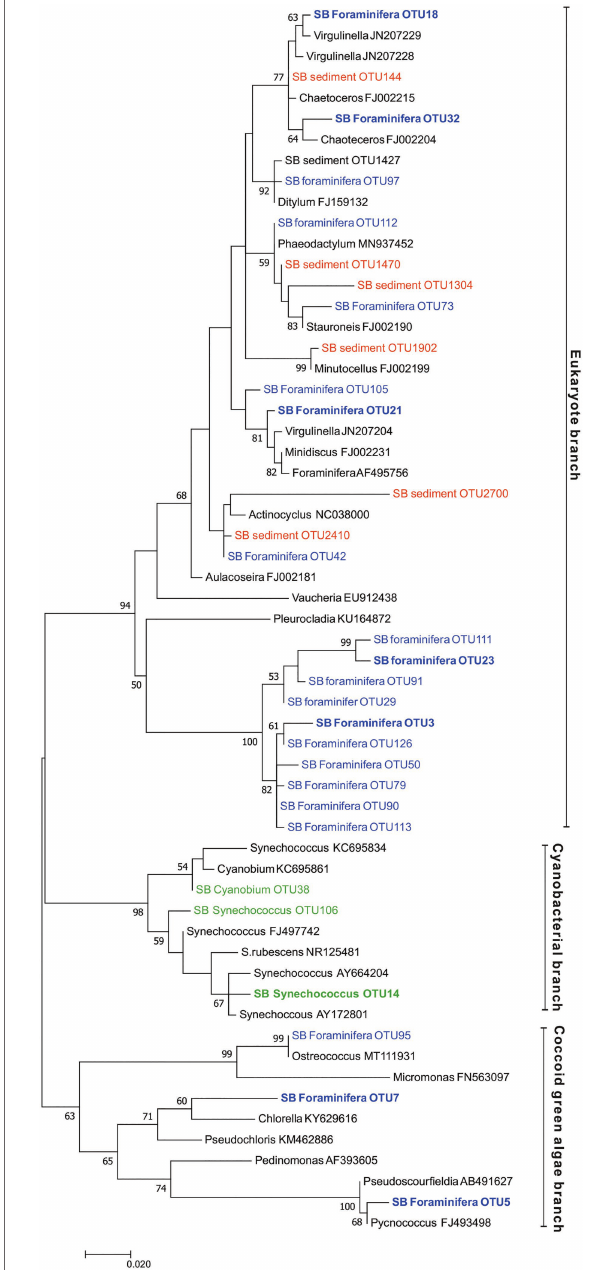
FIGURE 8 | Maximum likelihood tree based on Illumina MiSeq-derived 16S rRNA gene sequences indicating the position of chloroplast OTUs of foraminifera specimens (SB foraminifera OTU, blue color) and sediment samples (SB sediment OTU, orange color) as well as cyanobacterial OTUs (green color). Bootstrap values greater than 50% based on 1000 resamplings are shown at branch nodes. GenBank accession numbers are given for the closest relatives (in black color) after the taxonomic name. The most abundant OTUs are highlighted in bold.